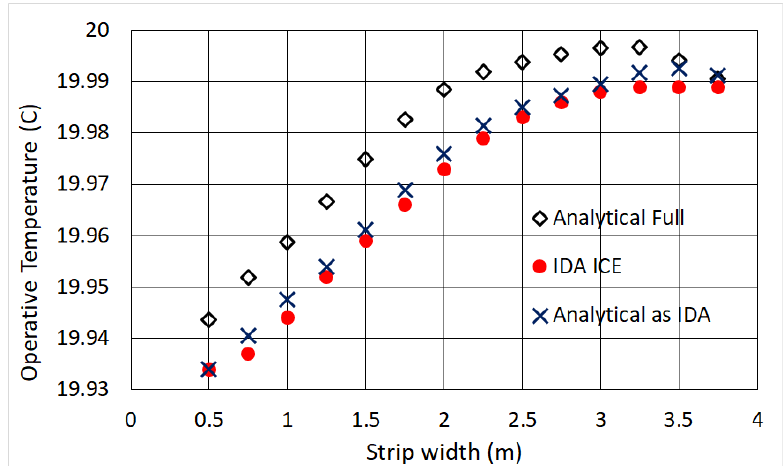
Figure 21. Operative temperature for a heated strip on the ceiling.